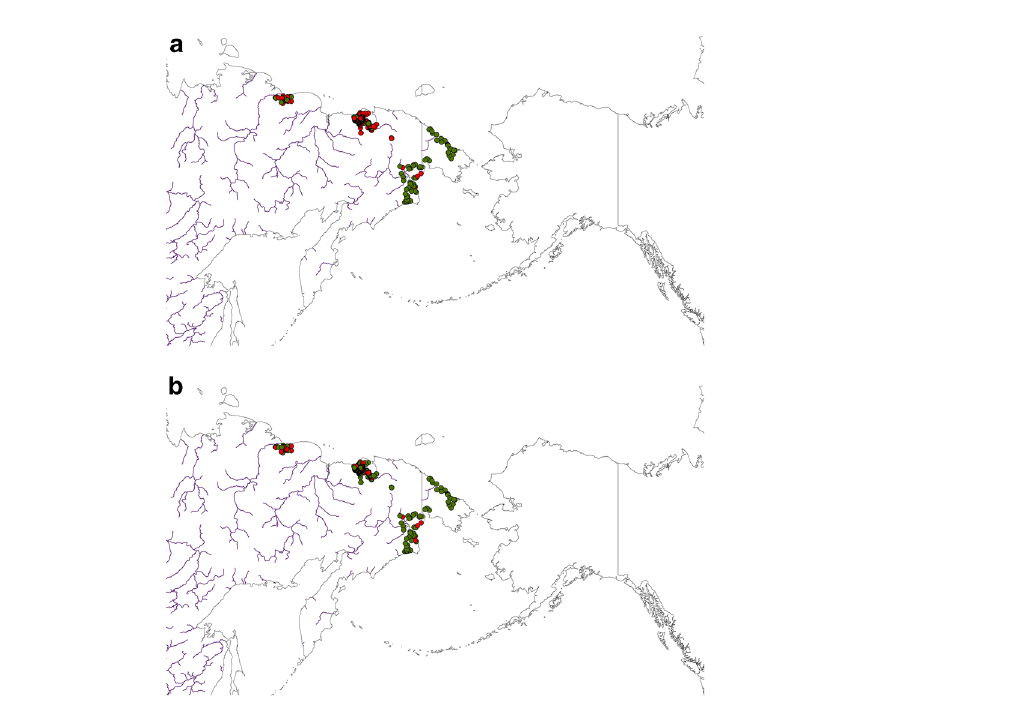
Figure 3. Best-available compiled raw data of Tundra Bean Goose (Anser fabalis) presence/absence for ( a ) Brood, and ( b ) Non-breeders in the study area. For both figures presence is shown in red and absence in green. Map created by FH with OpenSource QGIS and ArcGIS Desktop 10.6 academic